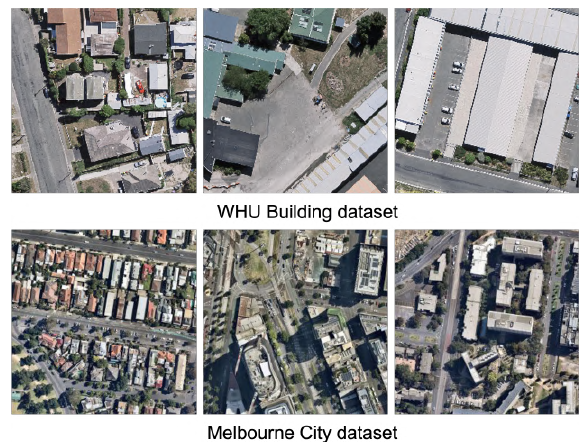
Figure 2 . Sample image tiles from WHU Building dataset (TR1) and Melbourne Building dataset